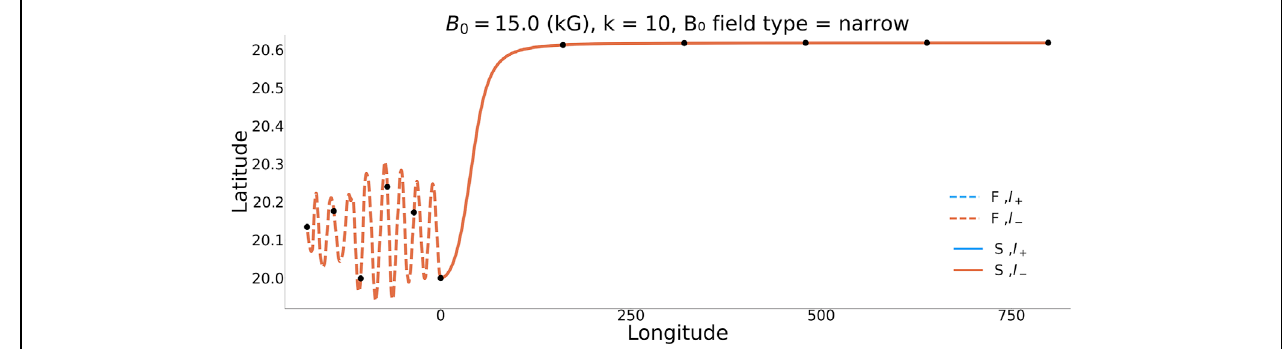
FIGURE 5 | Fast hydrodynamic branch wave energy trajectory embedded in the narrow band toroidal magnetic field, for a narrow latitudinal range around the maximum of the background magnetic field.